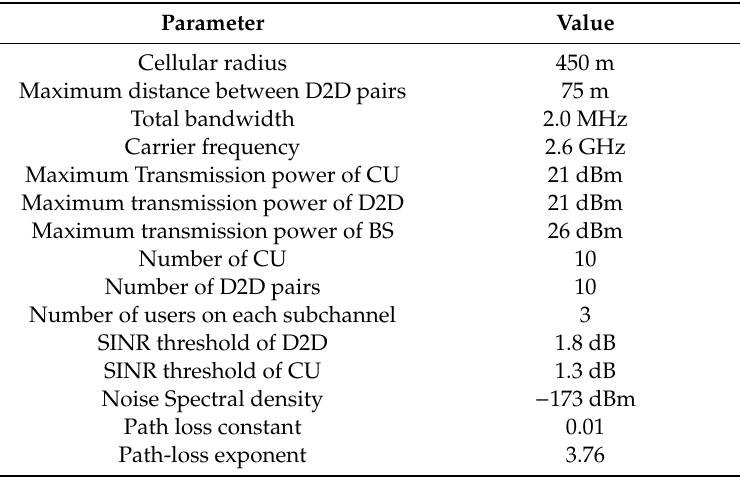
Table 1. Propose the simulation parameters of the study.